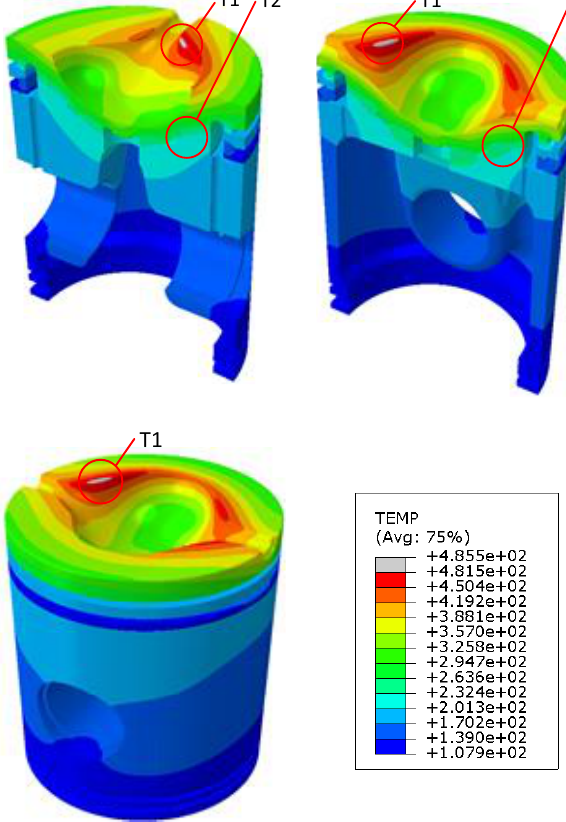
Fig. 11. Temperature distribution on the surface of the